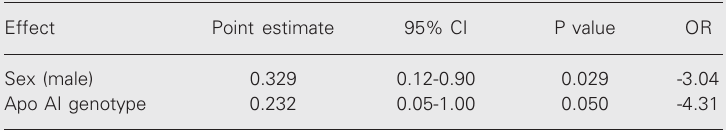
Table 4. Odds ratio (OR) and 95% confidence interval (CI) relating the prevalence of an atherosclerotic lesion greater than the 50th percentile and specific genotypes in mice expressing combinations of apolipoprotein (apo) AI, lecithin-cholesterol acyl trans- ferase, and cholesteryl ester transfer protein.